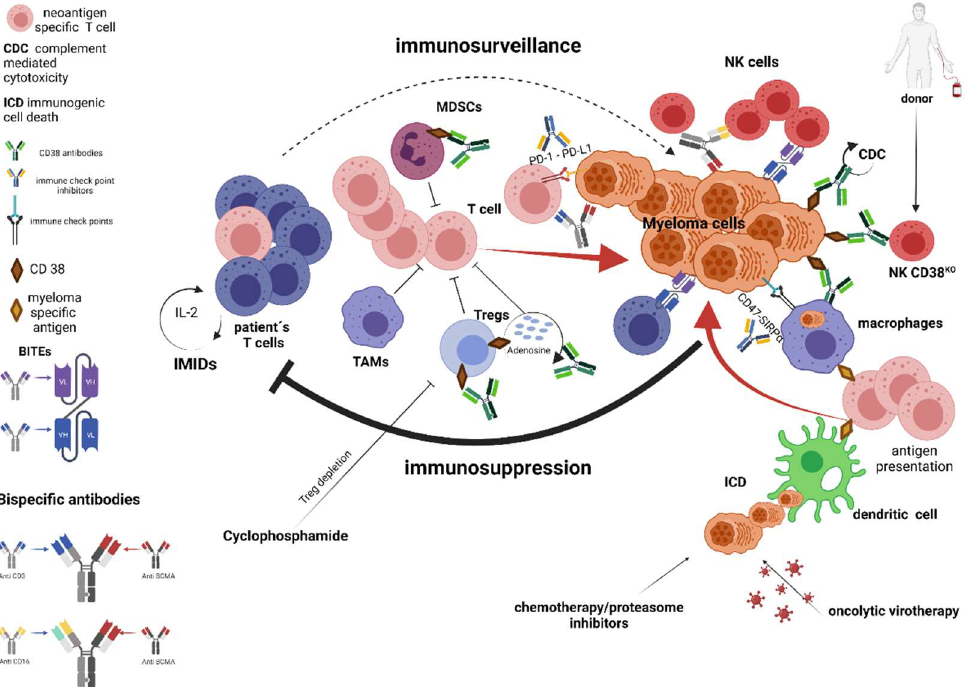
Figure 4. Strategies mitigating immune resistance—reviving of existing immune responses and stimulating innate immune system. ICD: Immunologic cell death; IMIDs: Immunomodulatory drugs; MILs: Marrow infiltrating lymphocytes; MDSCs: Myeloid-derived suppressor cells; TAMs: Tumor-associated macrophages, Tregs: Regulatory T cells.